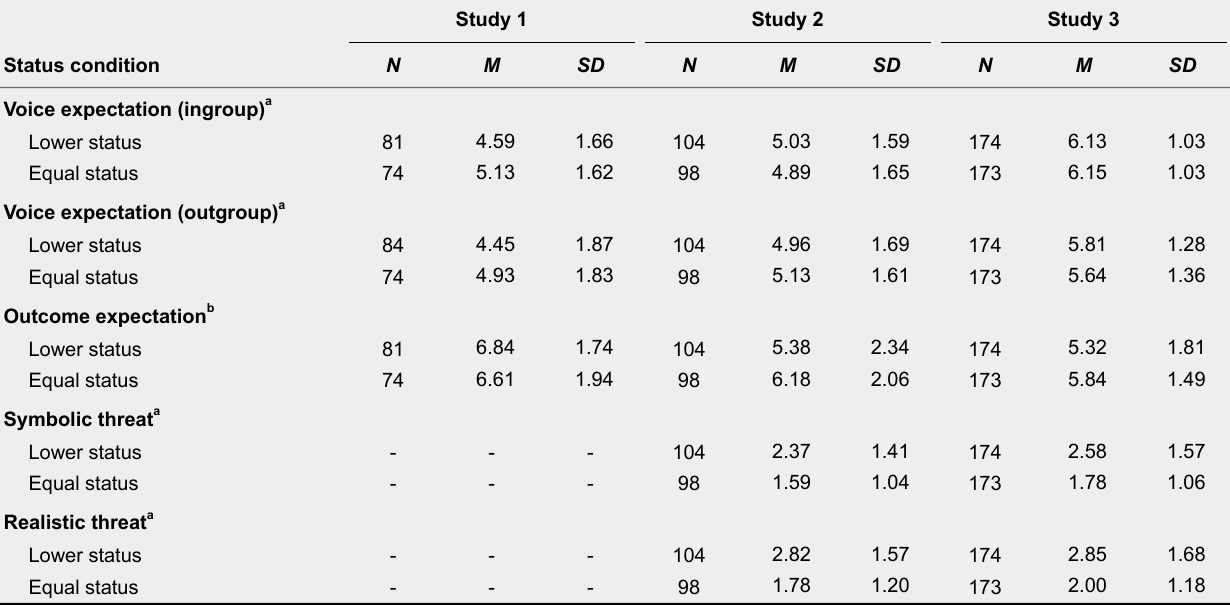
Mean Score Differences in Lower Outgroup Status Versus Equal Outgroup Status Conditions in the Key Measured Variables (Studies